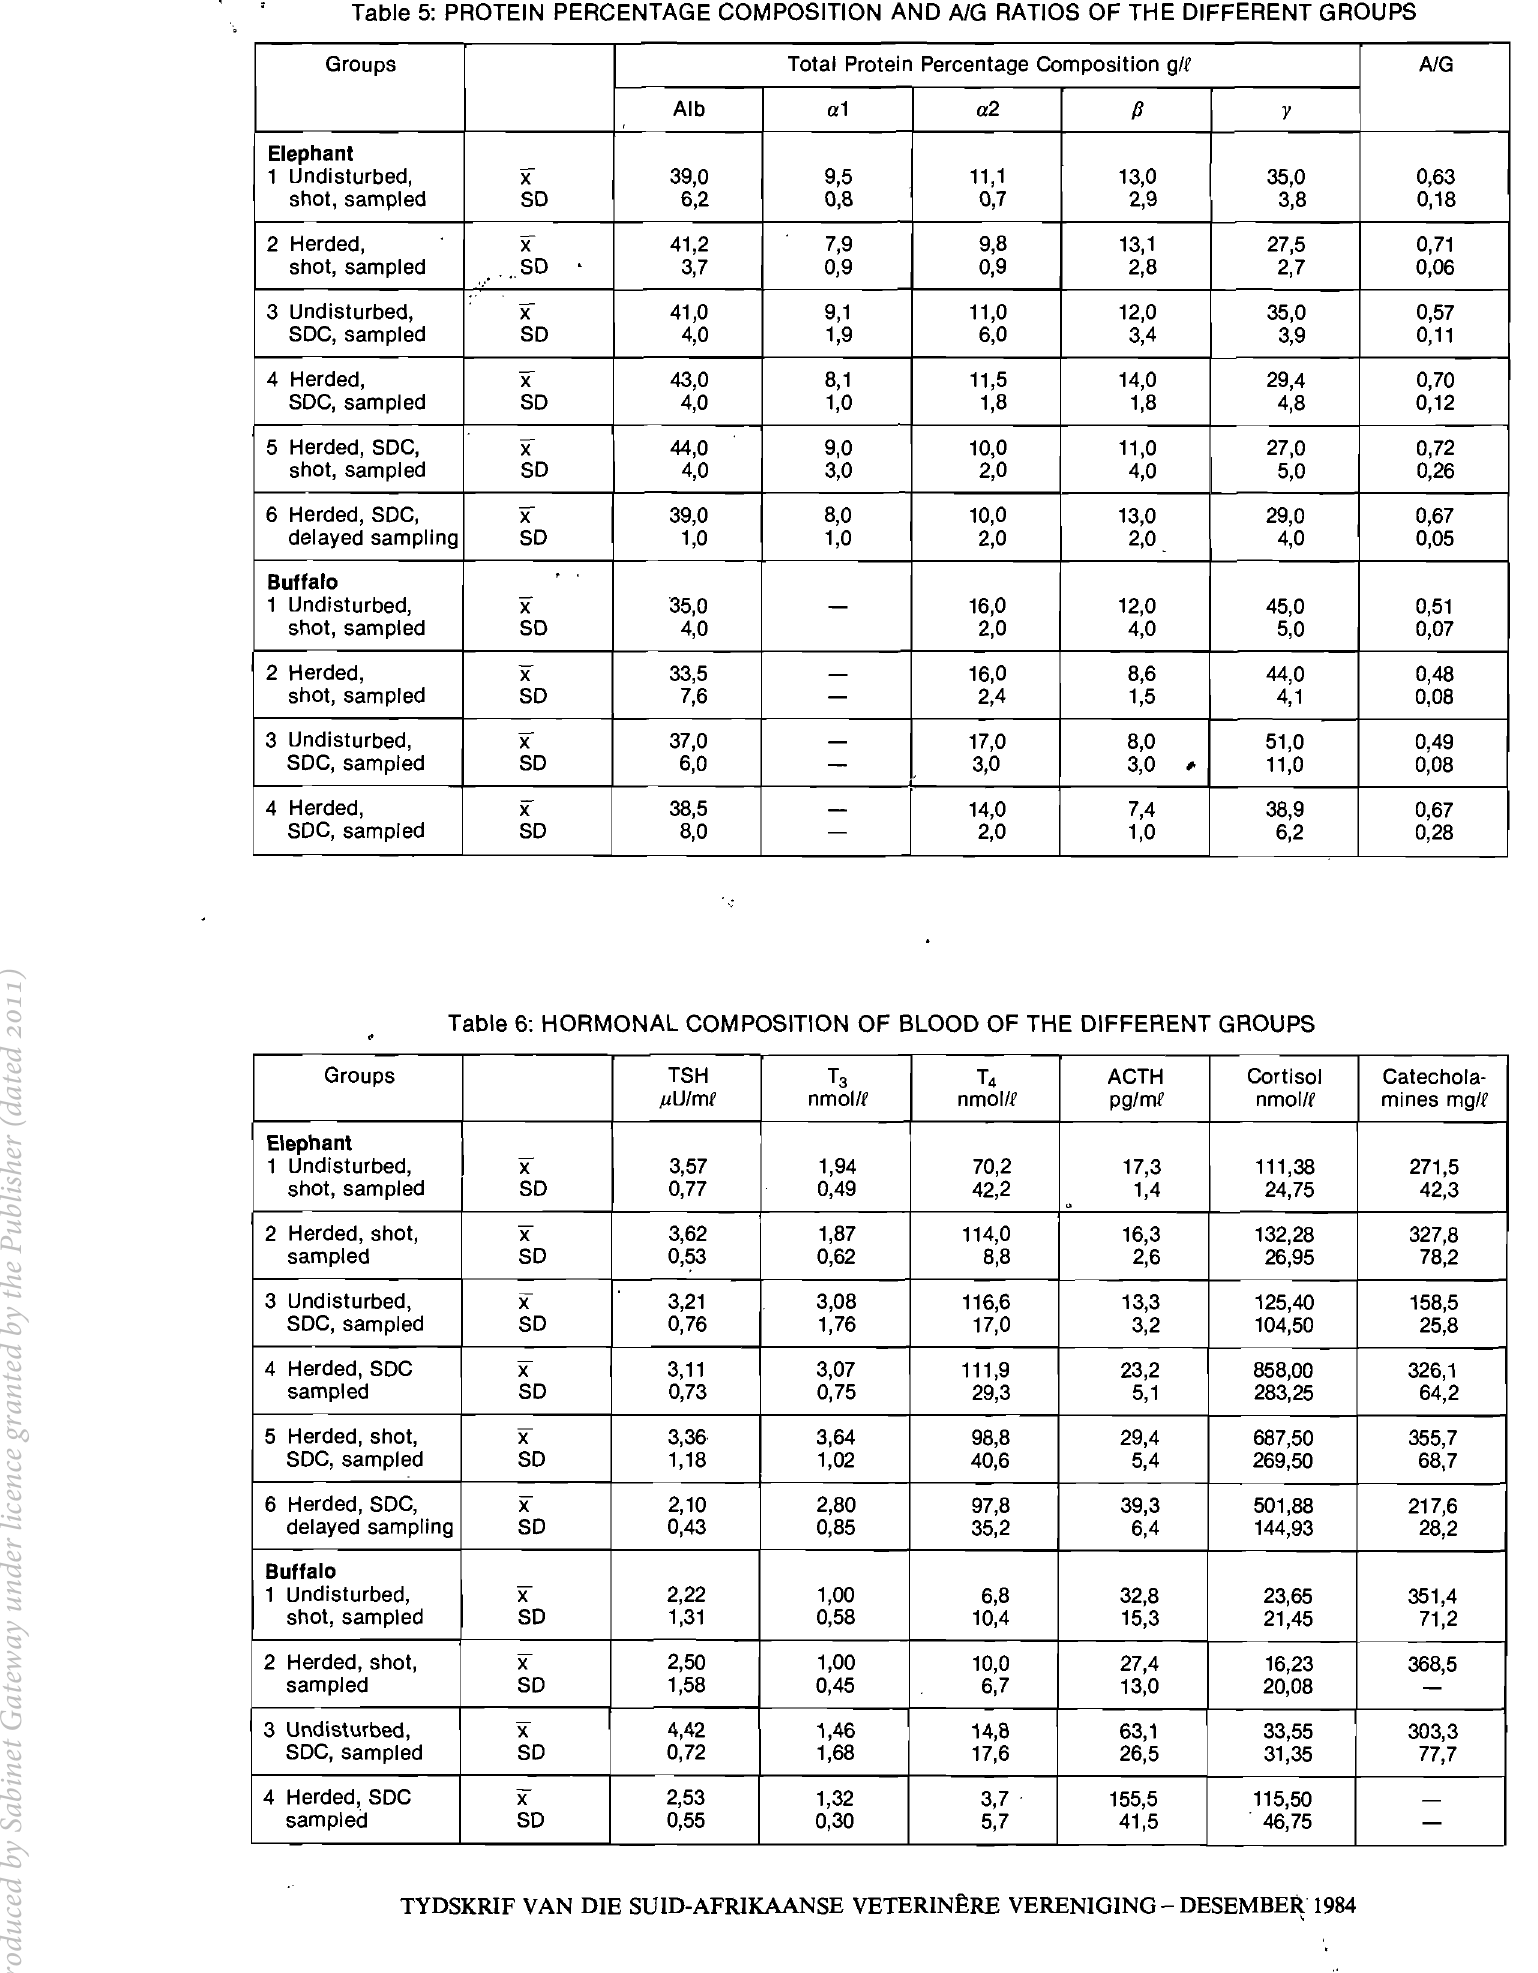
Table 5: PROTEIN PERCENTAGE COMPOSITION AND A/G RATIOS OF THE DIFFERENT GROUPS Groups